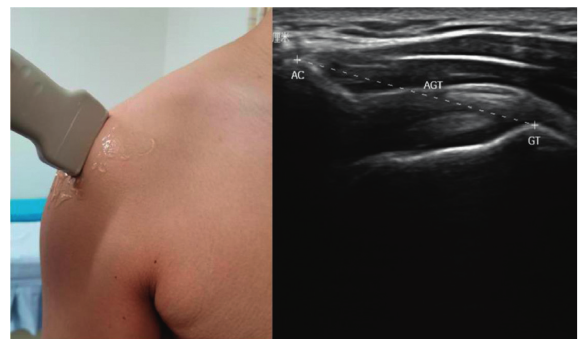
Figure 2: Measurement of acromion-greater tuberosity (AGT) for shoulder subluxation by using musculoskeletal ultrasound imaging technique. AC indicates acromion; GT indicates greater tuberosity.